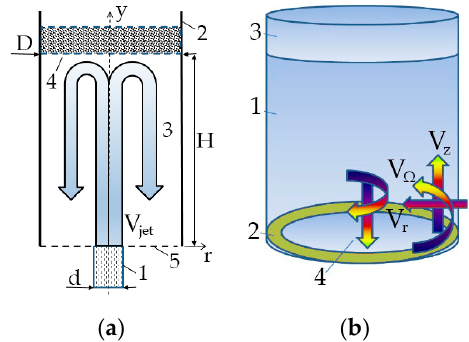
Figure 2. Simulation models: ( a ) central solution supply (tube 1 for flowing into cylindrical shaper 2 with solution 3, crystal surface 4, lower part of shaper where solution is draining 5); ( b ) peripheral solution supply (shaper 1, ring area for solution inflowing 2, crystal 3, lower part of shaper where solution drains out 4).